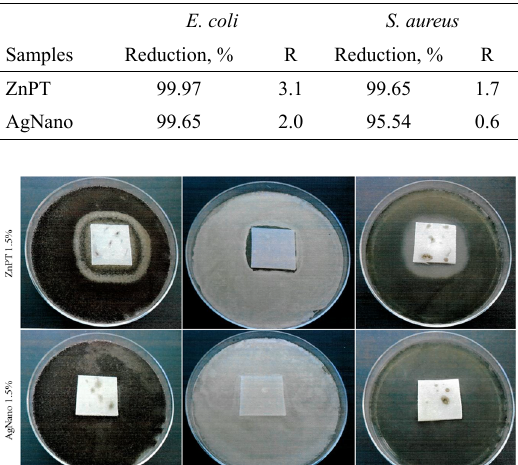
Table 3. Percentage of bacterial population reduction after 24 h of incubation and (R) antibacterial effectiveness values.